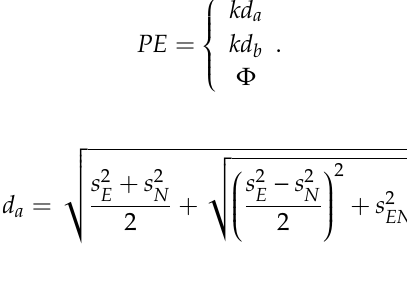
Figure 4. Elliptical representation of an SBAS based protection area.